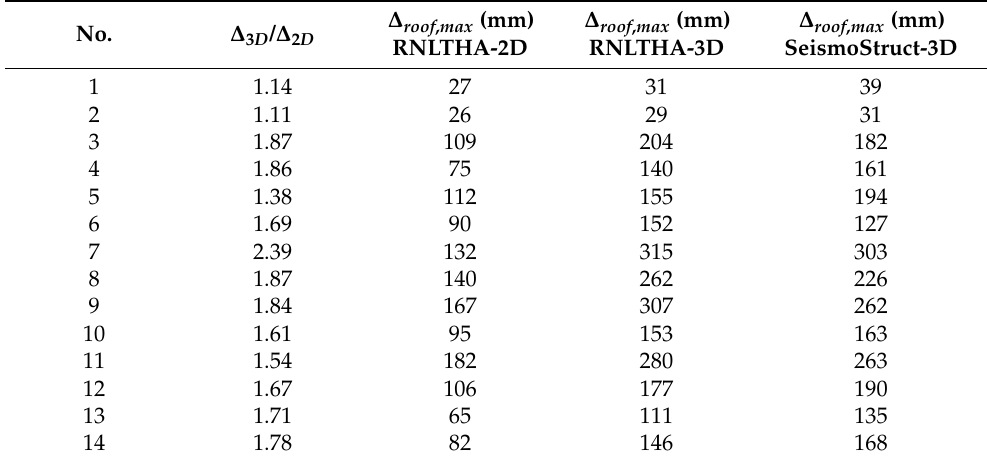
nonlinear time history analysis in 3D (RNLTHA-3D) and SeismoStruct.